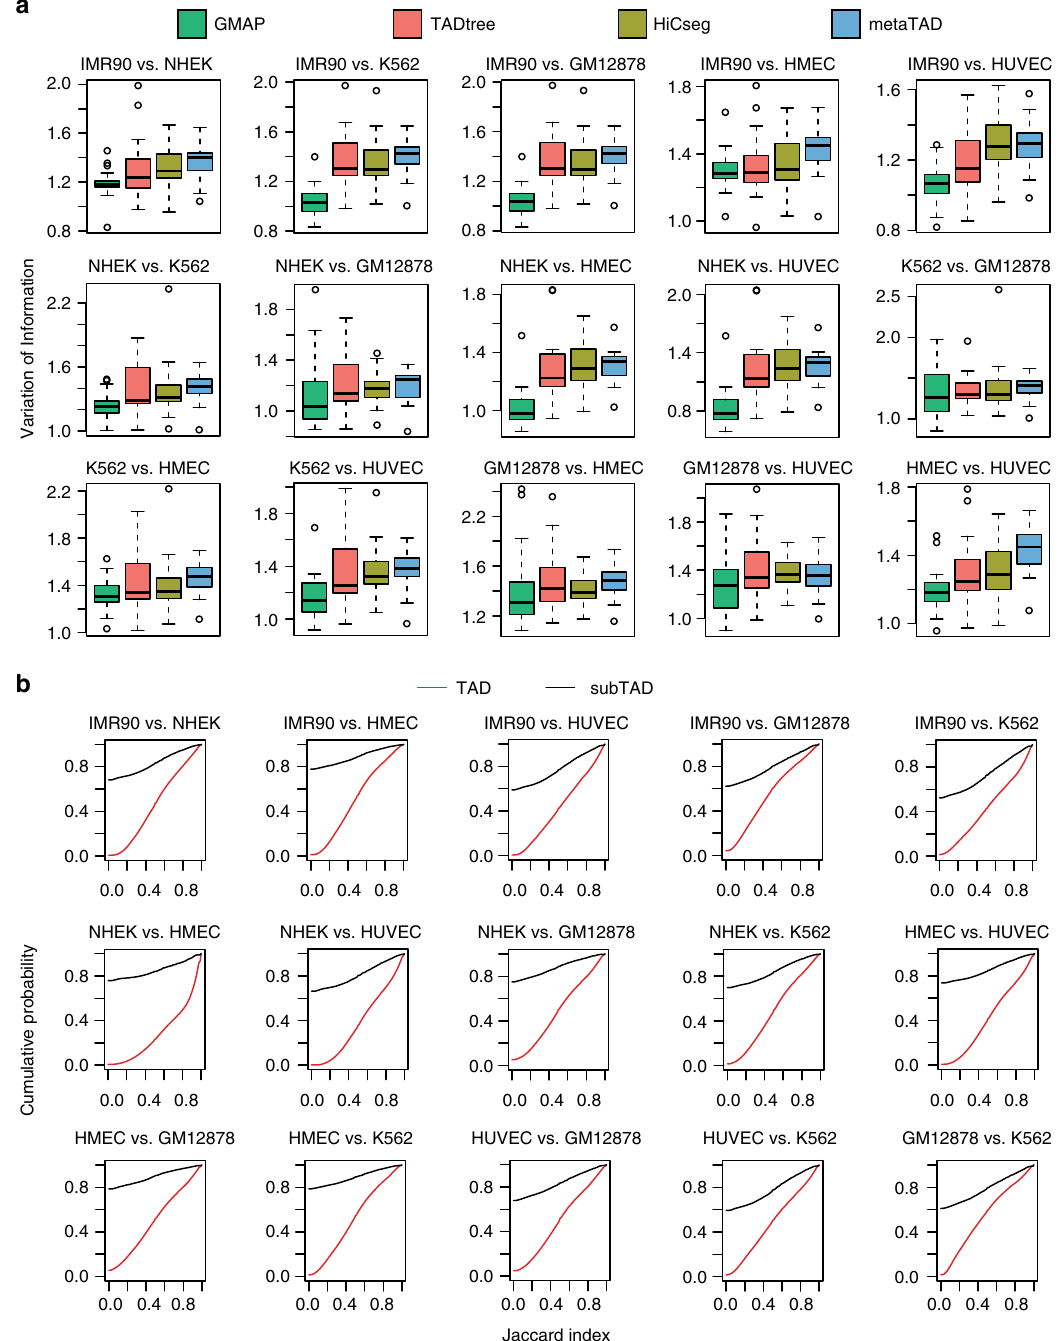
Fig. 4 SubTAD boundaries are more dynamic than TAD boundaries across different cell lines. a Pairwise similarity of TADs across six human cell lines, GM12878, HMEC, HUVEC, IMR90, K562, NHEK. In all but four pairwise comparisons, the difference between GMAP and the other three methods is signi fi cantly different based on t -test ( P < 0.05). The whiskers represent the most extreme data point which is no more than 1.5 times the interquartile range. b Comparison of pairwise similarities for TADs and subTADs across six human cell lines. The cumulative probability plots show that subTAD boundaries are more dynamic across all pairwise comparisons of the six cell lines. In all pairwise comparisons, the cumulative distribution for subTADs is signi fi cantly different than the distribution for TADs based on KS test ( P <